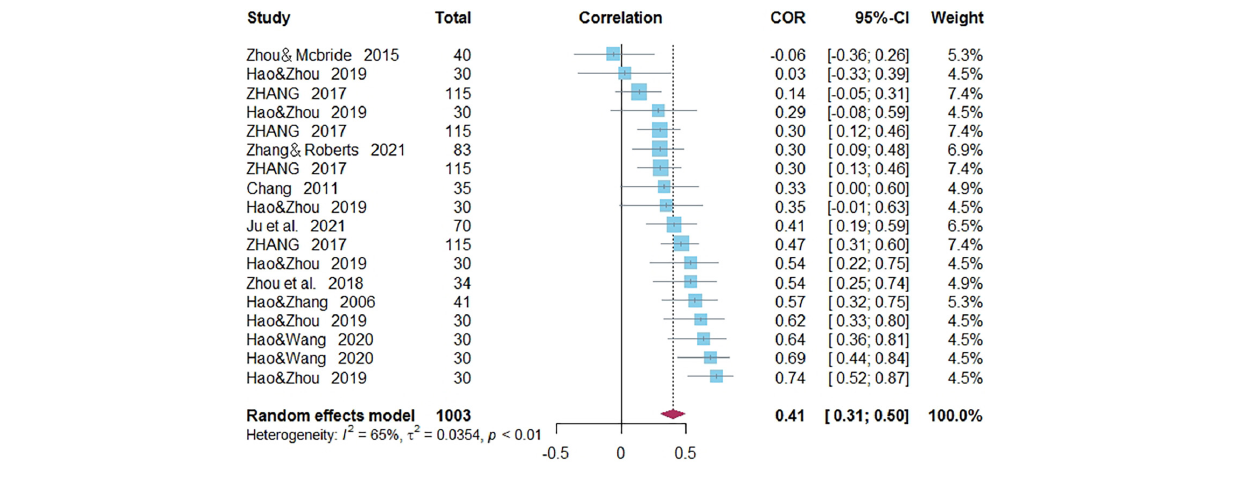
FIGURE 2 | Forest plot of the correlations between phonological awareness and Chinese word reading. TABLE 1 | Number of effect sizes, heterogeneity statistics, and Egger’s test of the relationship between phonological awareness, morphological awareness, orthographic awareness, rapid automatized naming, and Chinese word reading. Predictor Variables